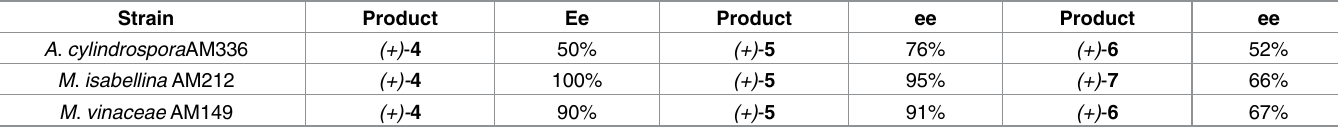
Table 2. The enantiomeric excess(ee %) of obtained biotransformation products. Strain